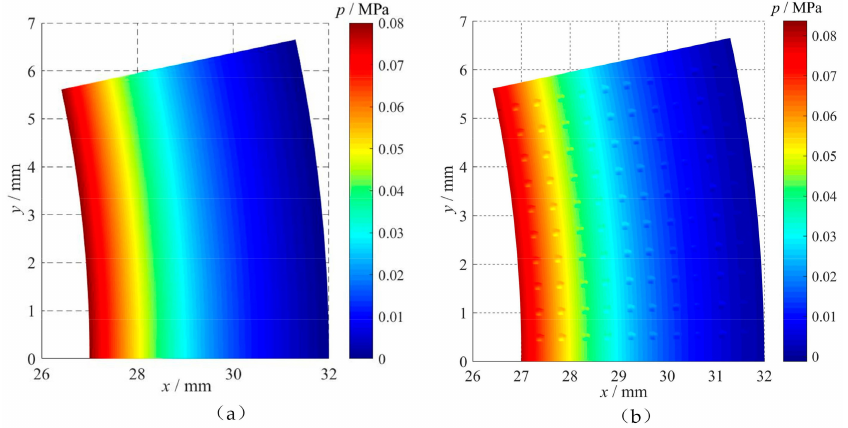
Figure 9. Pressure distribution of nontextured and textured oil film (( a ) is oil film with textures; ( b ) is oil film without textures).